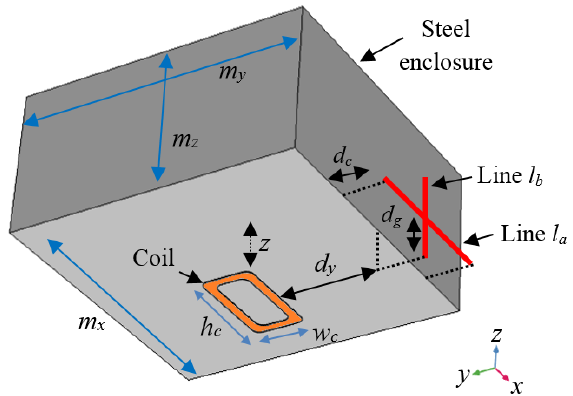
Figure 16. Setup of the simplified configuration.